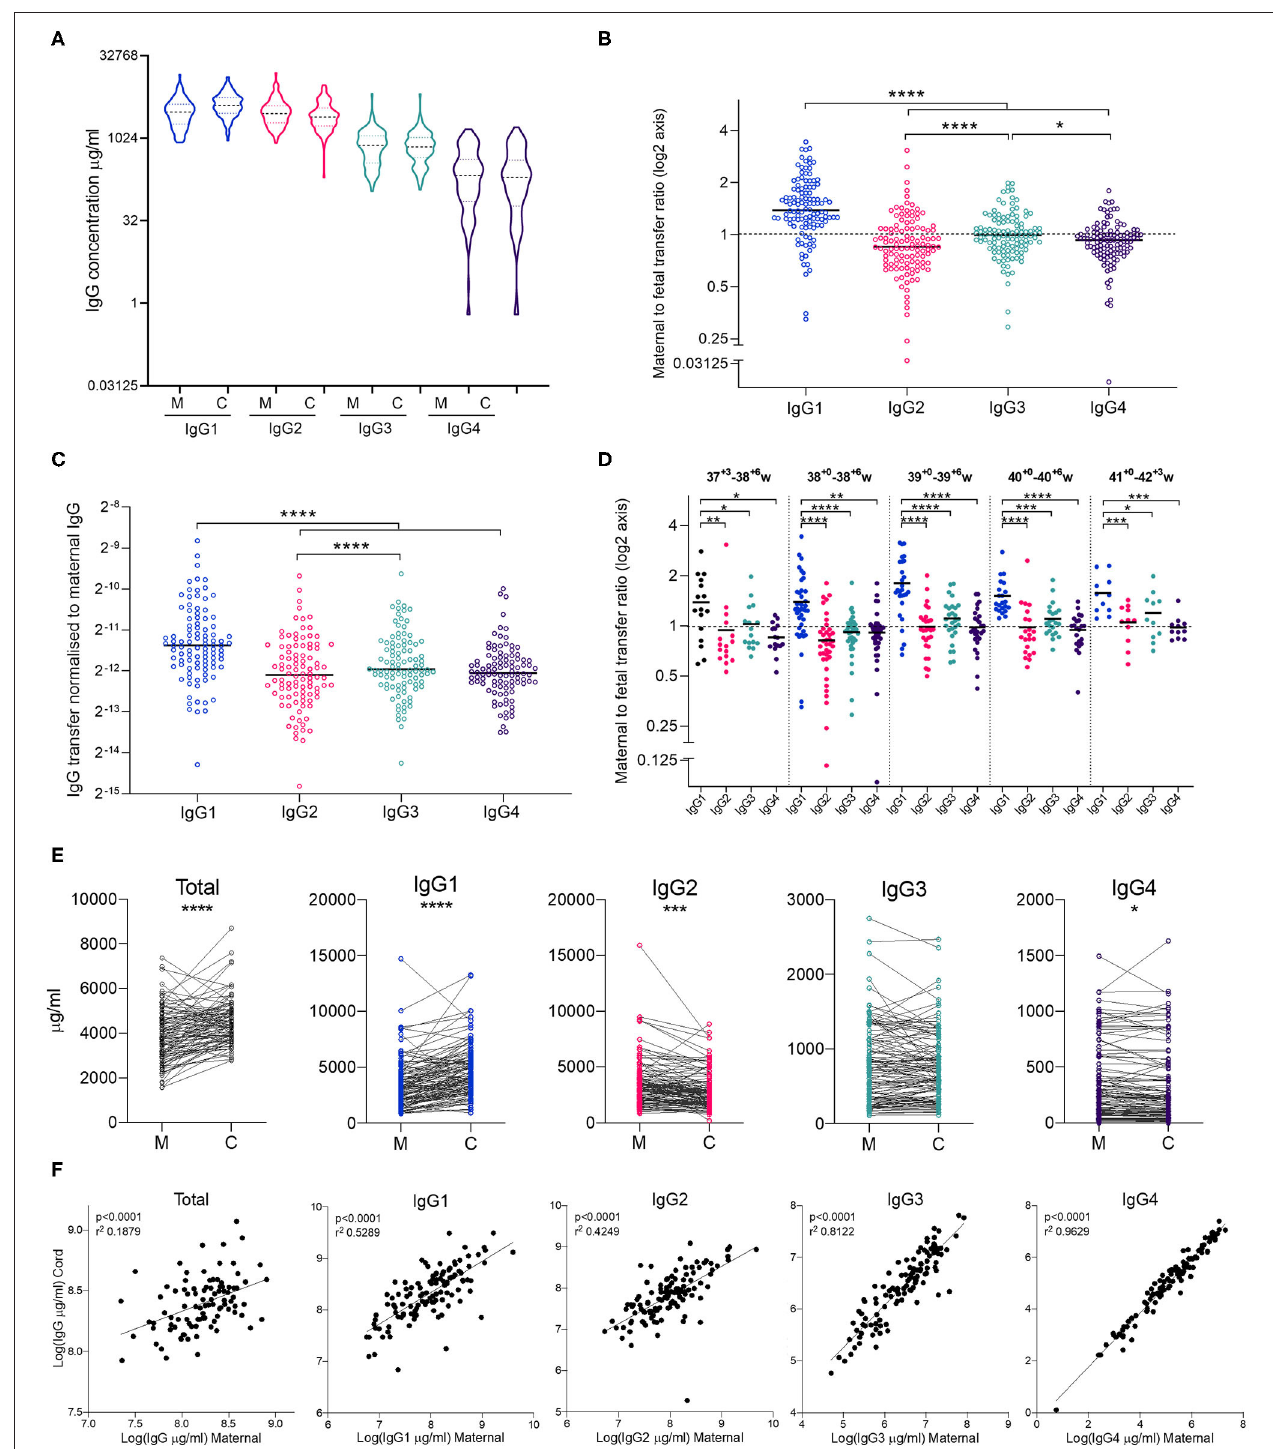
FIGURE 2 | Maternal and cord blood IgG subclass profiles and transfer ratios. (A) IgG1-4 concentrations ( µ g/ml) in maternal (M) and cord (C) blood on a log(2) axis. (B) Maternal to fetal transfer ratios of IgG1-4 represented on log(2) scale. Values > 1 indicates higher levels in cord blood, indicated by dashed line. Analysis performed on log(2) transformed transfer ratios, using Repeated Measures One Way ANOVA and Holm Sidak’s multiple comparisons test. (C) Maternal to fetal transfer ratios of IgG1–4 normalized to levels of total IgG in maternal blood as an indicator of transfer efficiency. Analysis by Repeated Measures One Way ANOVA and Holm